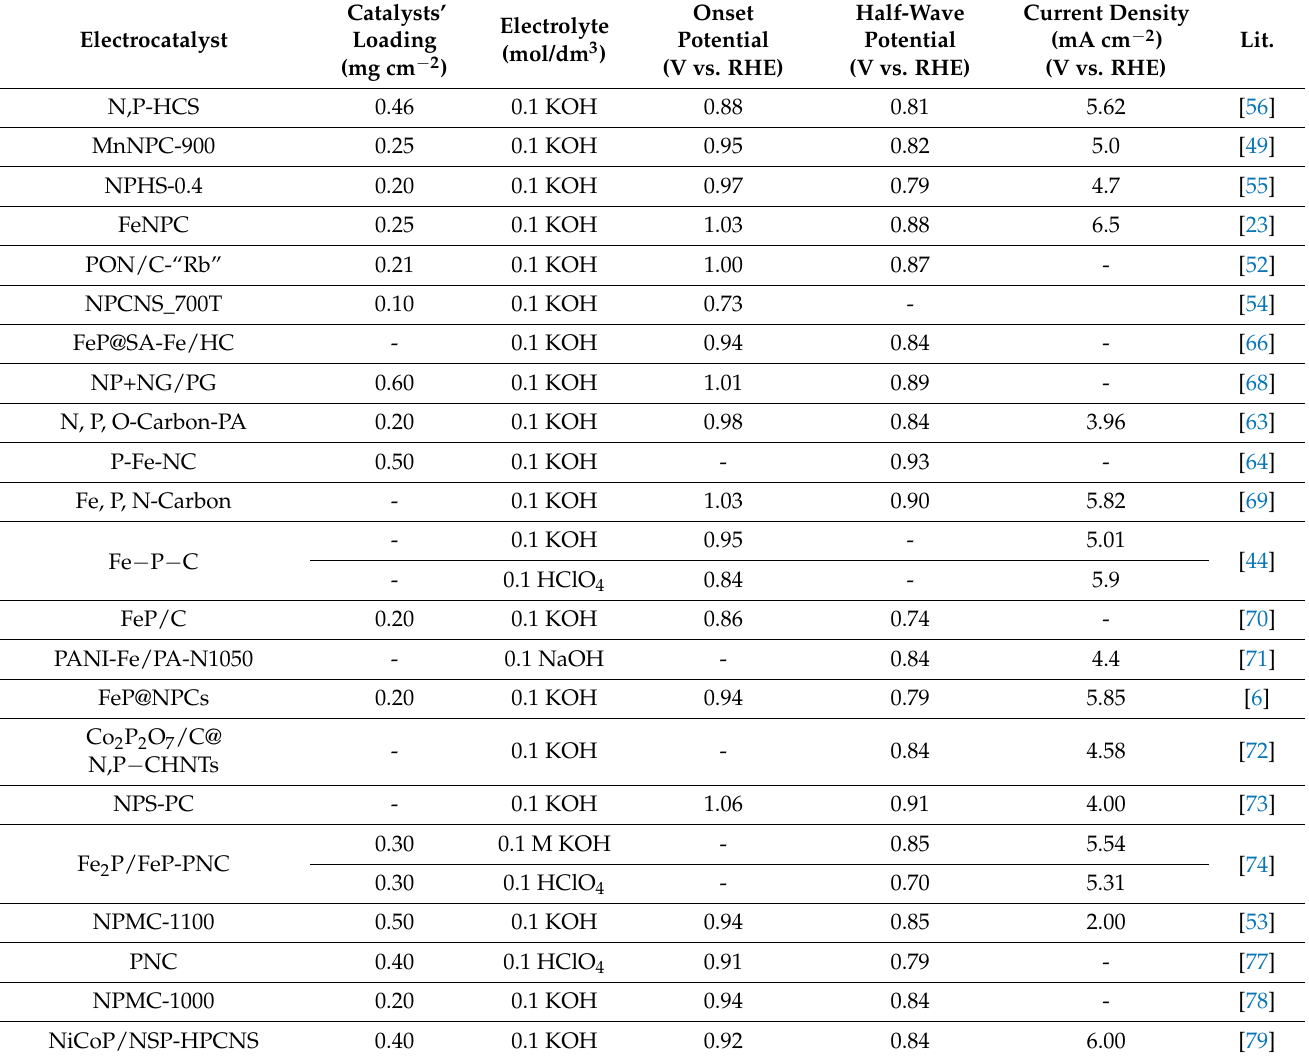
Table 4. ORR performance of PA-derived